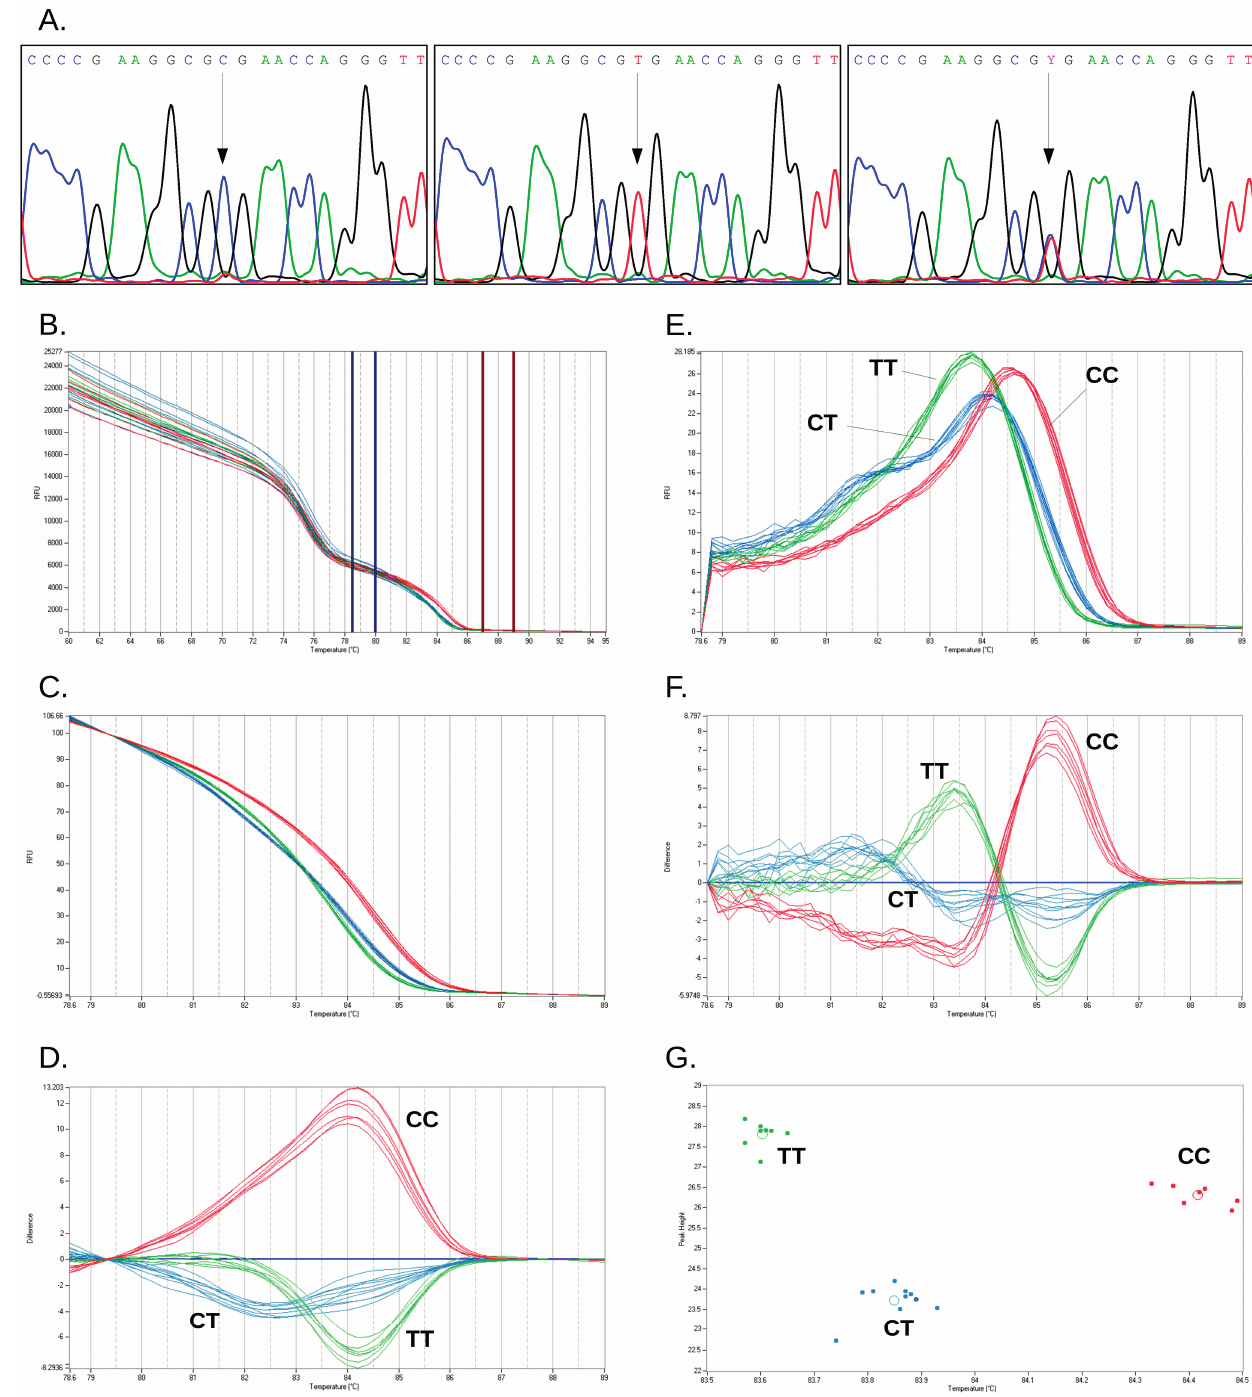
Figure 2. Genotyping of IL28B rs12979860 SNP by sequencing and high-resolution melting curve analysis. ( A ) Representative Sanger sequencing traces for the three genotypes of rs12979860 (from left to right: CC, TT, and CT); continuous arrows show SNP position; ( B – G ) Representative curves for high resolution melting of rs12979860 amplicons: ( B ) non-normalized melting curves and placement of normalization intervals; ( C ) normalized melting curves; ( D ) RFU difference clustering; ( E ) negative first derivative of the normalized melting curves; ( F ) dF/dT difference clustering; and ( G ) scatter-plot. IL28B genotypes: red, CC; green, TT; blue: